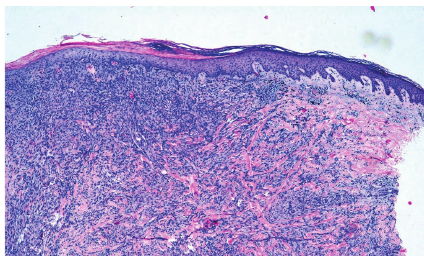
Figure 2: Dermal proliferation of fibroblastic-like cells and black